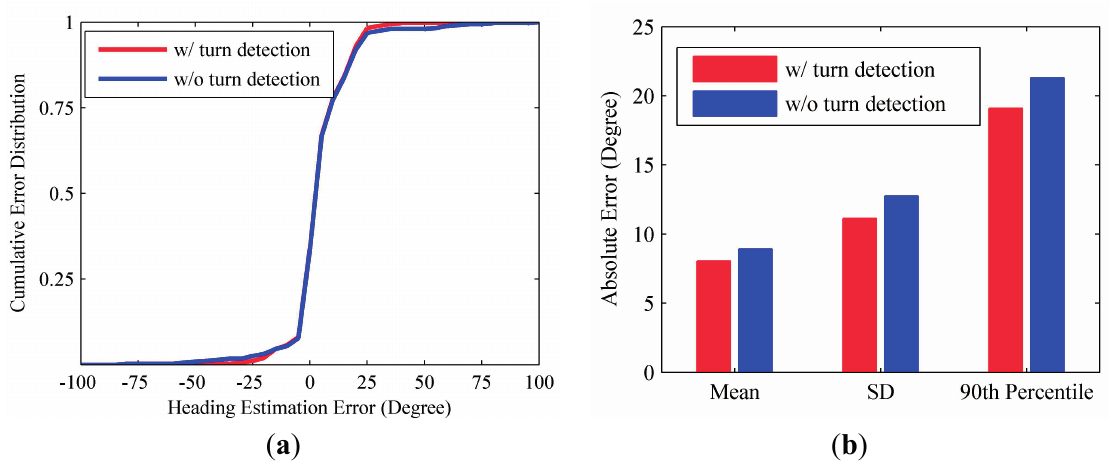
Figure 10. Heading estimation performance comparisons between RMPCA with and without turn detection. ( a ) Error distribution; ( b ) Statistical results of the absolute